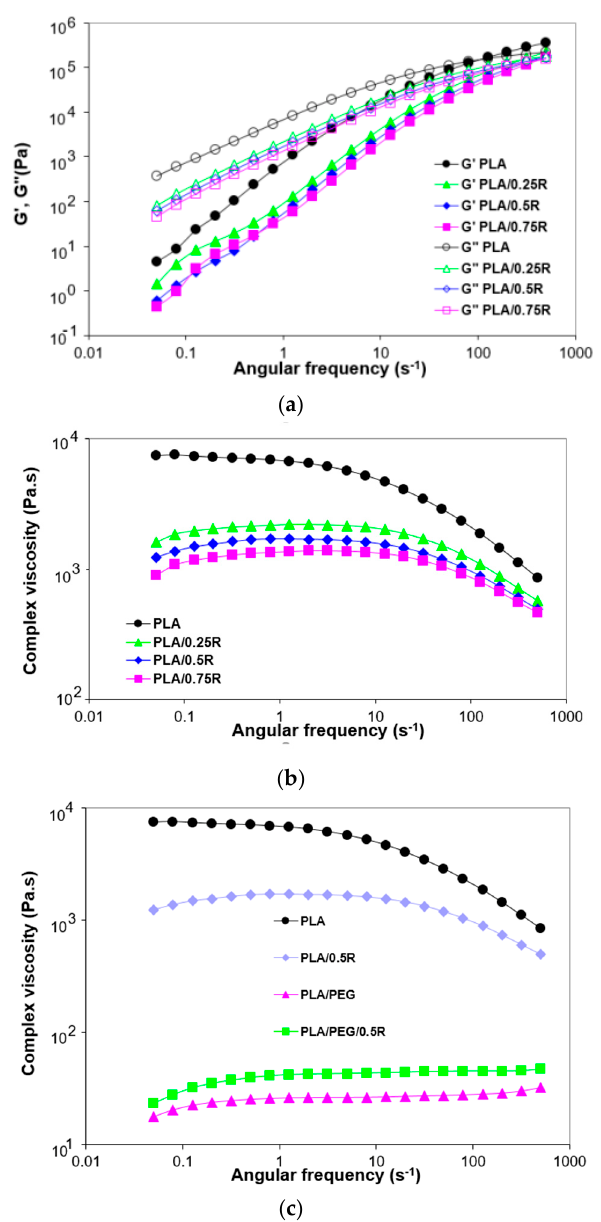
Figure 6. Angular frequency dependence of the storage modulus and loss modulus ( a ) and complex viscosity ( b – c ) for PLA, PLA/R and PLA/PEG/R systems.